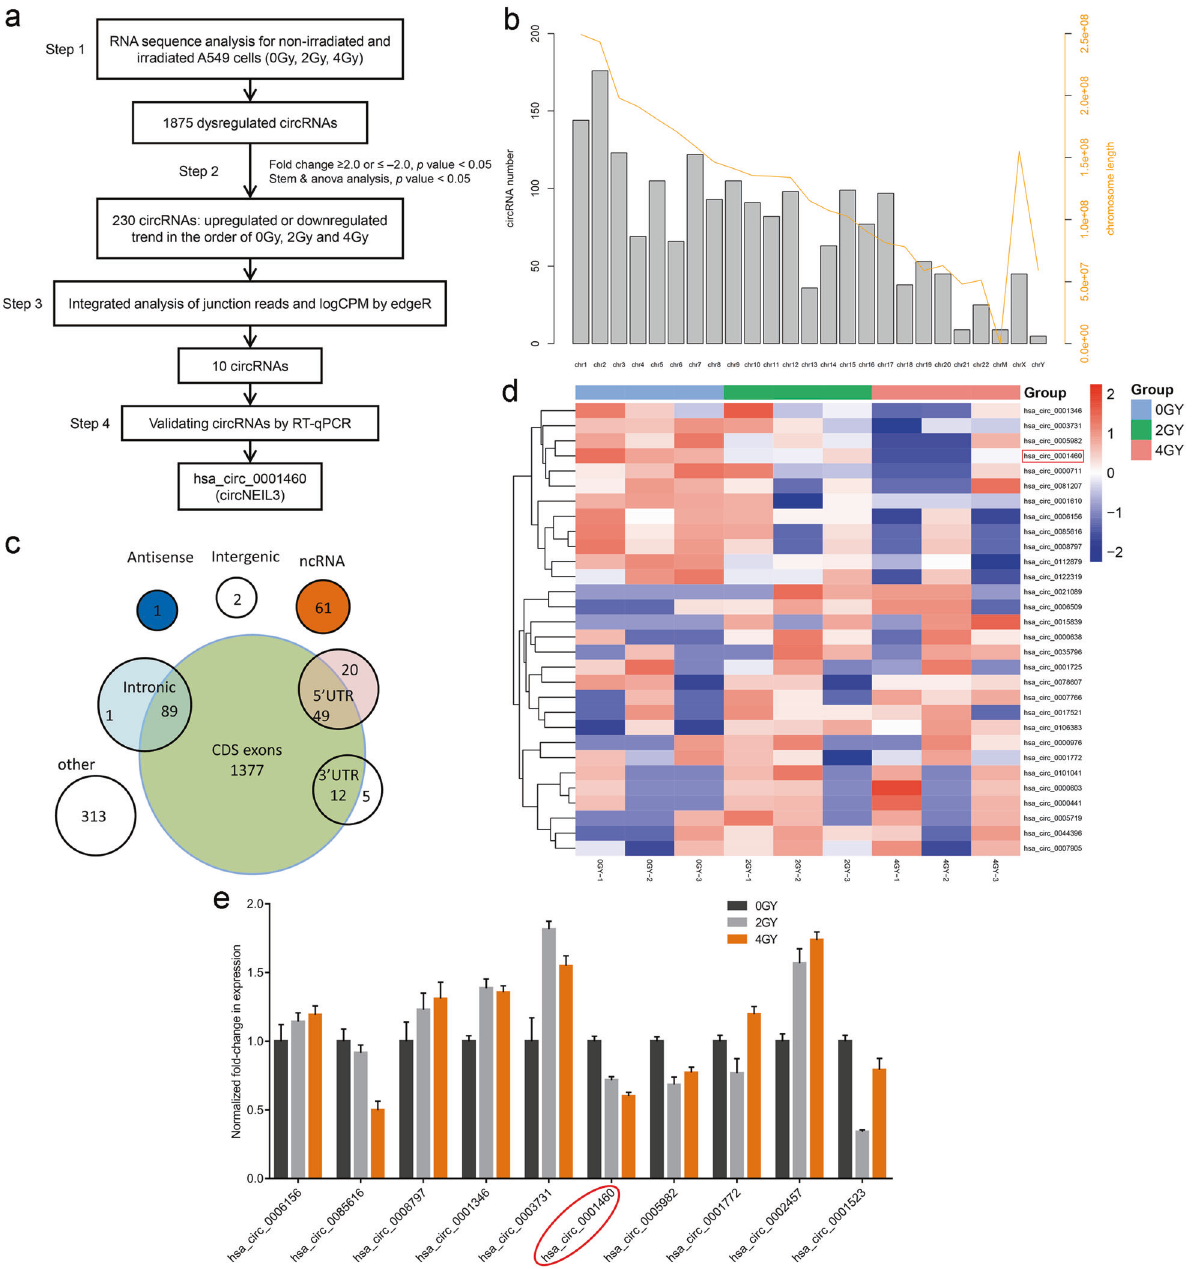
Fig. 1 The circRNA expression pro fi le work fl ow in the irradiated LUAD cells. a Flow chart for identifying and validating circRNAs in A549 cells. b Distribution map of circRNAs based on chromosome location. c Distribution map of circRNAs based on category. d Heatmap showing the top 15 most upregulated and top 15 most downregulated circRNAs in A549 cells treated with either 0, 2, or 4 Gy radiation, respectively. e Ten most representative circRNAs veri fi ed using